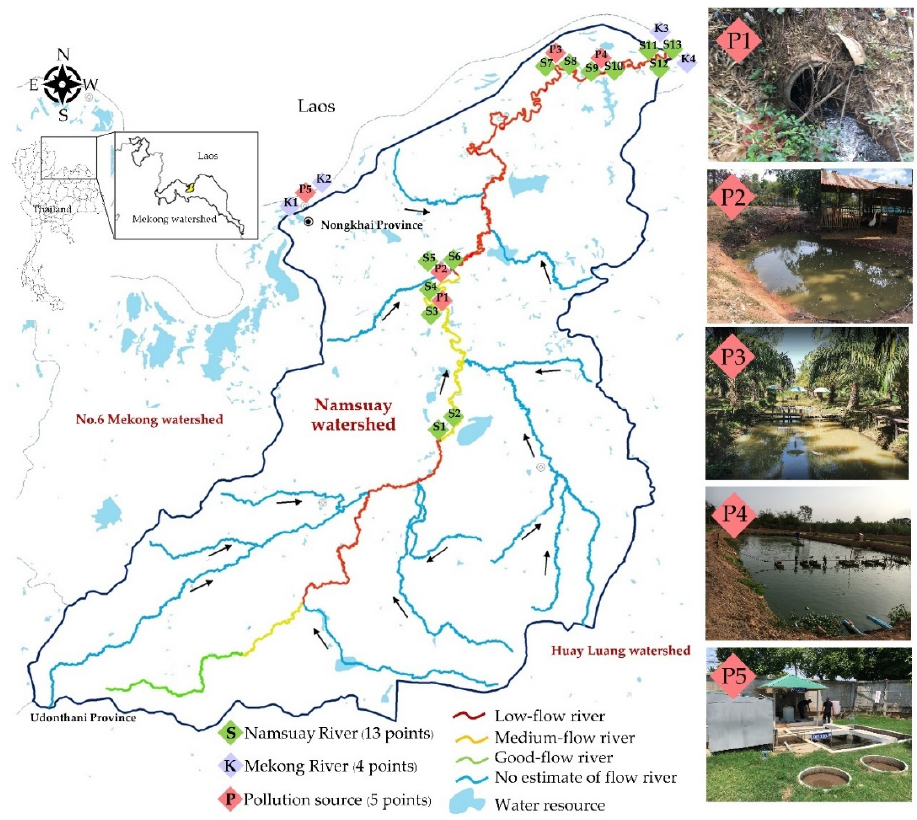
Figure 1. Study area and sampling sites. In total, 44 water samples were collected from 22 sites in the Nongkhai Province, northeast Thailand. The types of water sampling sites were: surface water (S1–S13 and K1–K4), wastewater (P1–P3), and discharge water